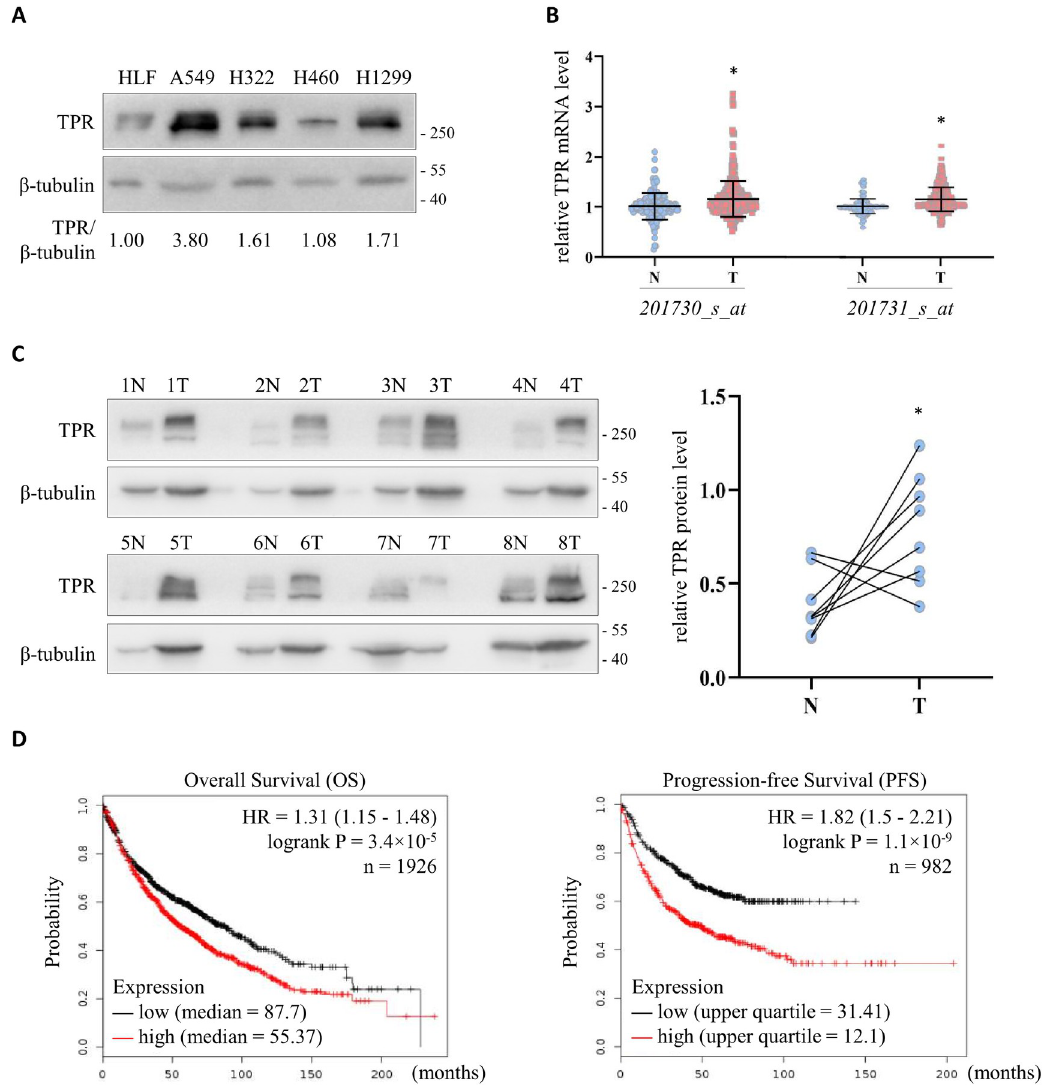
Fig 3. Elevated expression of TPR in lung cancer cell lines and tissues. (A) Western blot to detect the expression of TPR in lung cancer cell lines. HLF (human lung fibroblast) served as the normal control, while A549 (lung adenocarcinoma cell), H322 (bronchioalveolar carcinoma cell), H460 (large cell lung cancer cell) and H1299 (lung carcinoma cell) were representative lung cancer cells. β -tubulin was used as the loading control. (B) TPR mRNA level in human lung cancer (T, n = 356) and non-tumor (N, n = 161) tissues. Data were extracted from GSE7670, GSE10072, GSE19188 and GSE31210, normalized to the median value of the non-tumor tissues in each dataset, and compiled for analysis. � P < 0.05 by Student’s t -test. (C) Left: Western blot to detect the expression of TPR in paired tumor (T) and adjacent non-tumor (N) tissues from lung cancer patients. β -tubulin served as the loading control. Right: Quantification of TPR expression relative to β -tubulin in patient samples. � P < 0.05 by Student’s t -test for pairwise comparison. (D) The prognostic value of TPR mRNA level in lung cancer patients from KM plotter. Overall survival (OS, left) and progression-free survival (PFS, right) curves were plotted using 201731_s_at, which was selected as the optimal microarray probe to represent TPR by JetSet. The low and high TPR expression patient cohorts were compared by a Kaplan-Meier survival analysis, and the hazard ratio (HR) with 95% confidence intervals and logrank P value were